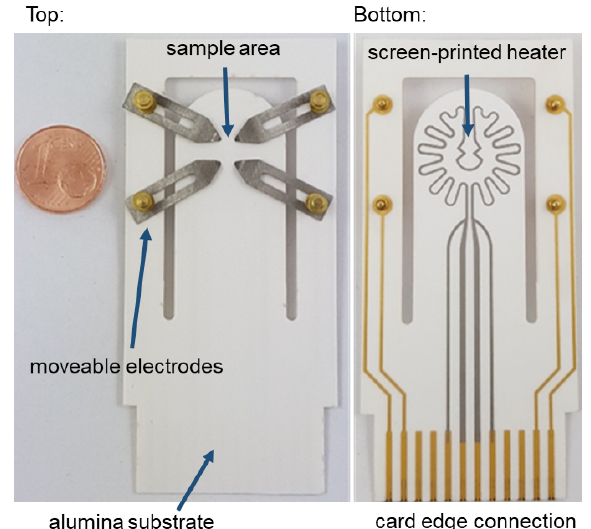
Figure 4. Produced sample holder made of an alumina substrate with four movable, spring-mounted Inconel bars for electrical con- tact on the top side. On the bottom side there is a screen-printed platinum heating structure, gold leads, and connection pads for the card edge